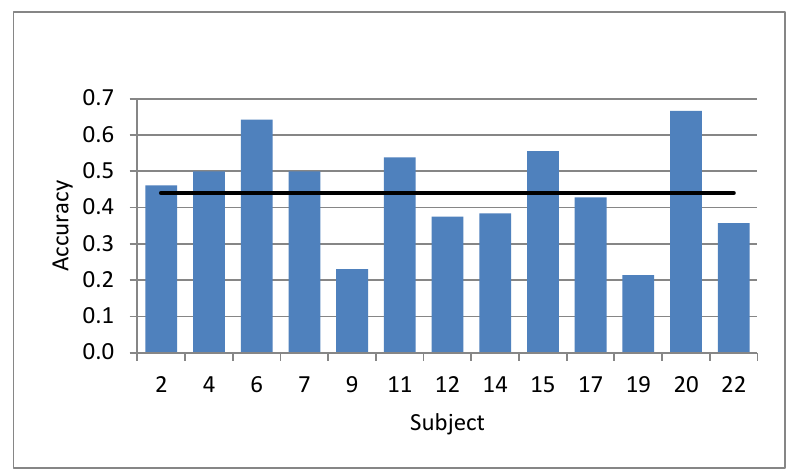
Figure 7. Perception accuracy in L3 German for obstruent devoicing at T2.